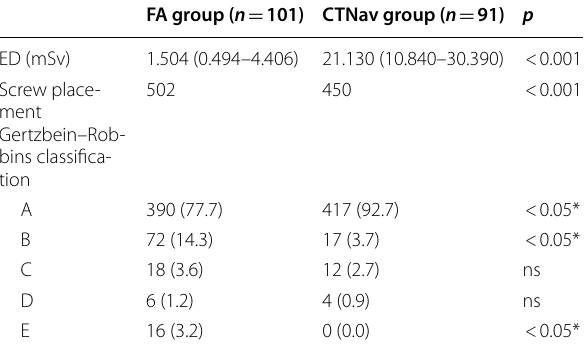
Table 4 Radiation dose exposure and screw placement accuracy